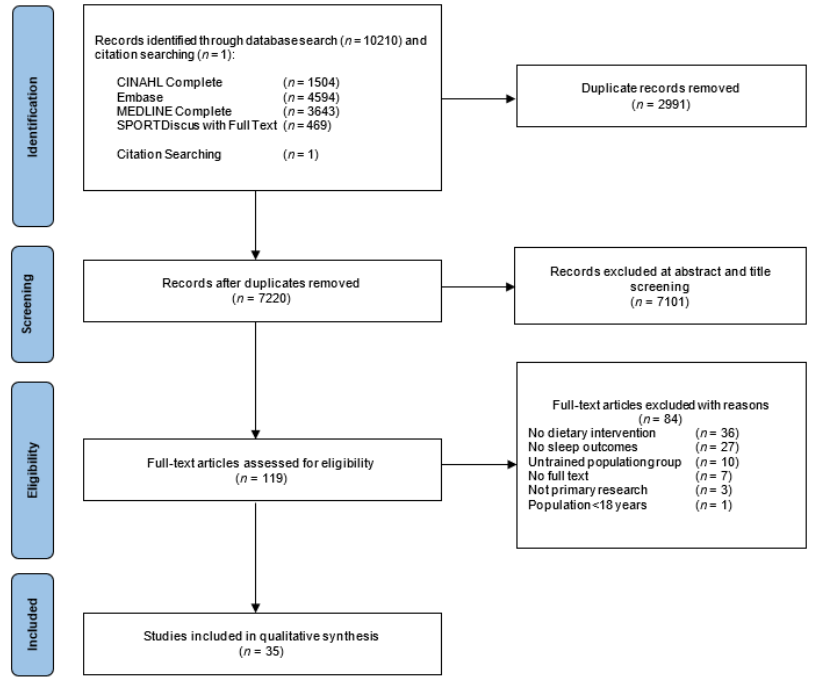
Figure 1. PRISMA flow chart for the selection of included studies.